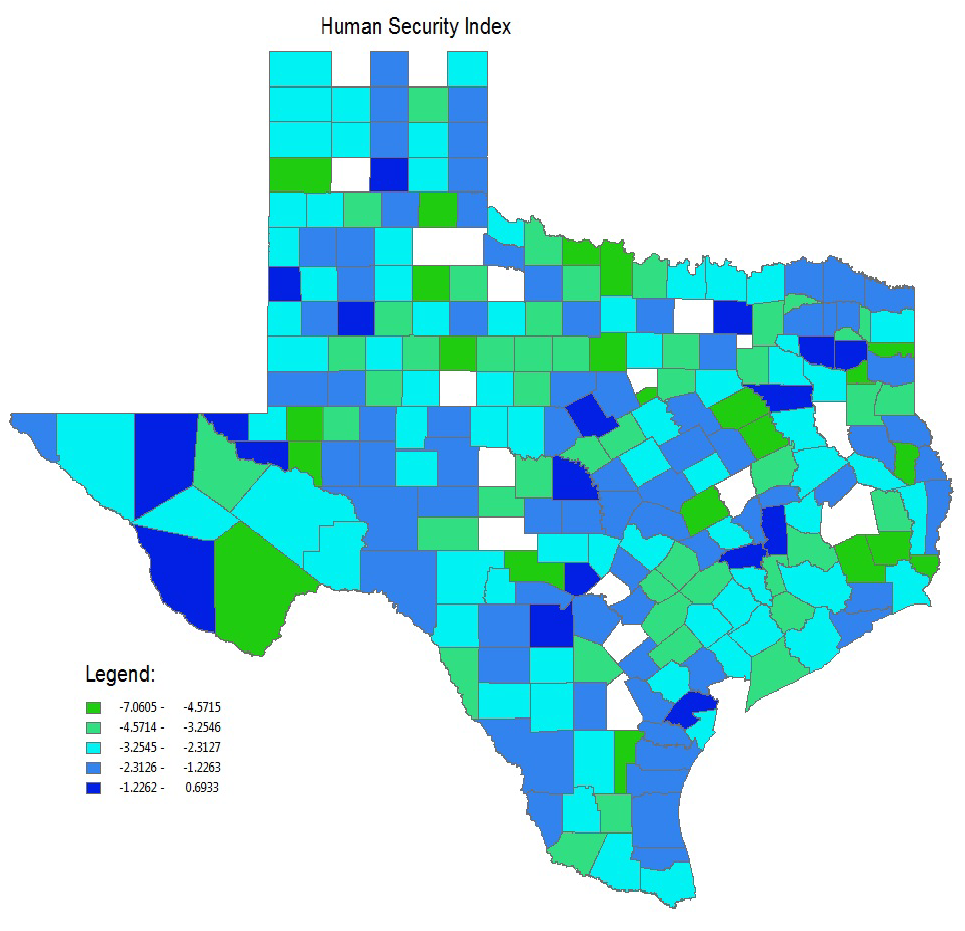
Figure 1. ( a ) Total Human Security Index by Texas county; ( b ) Environmental